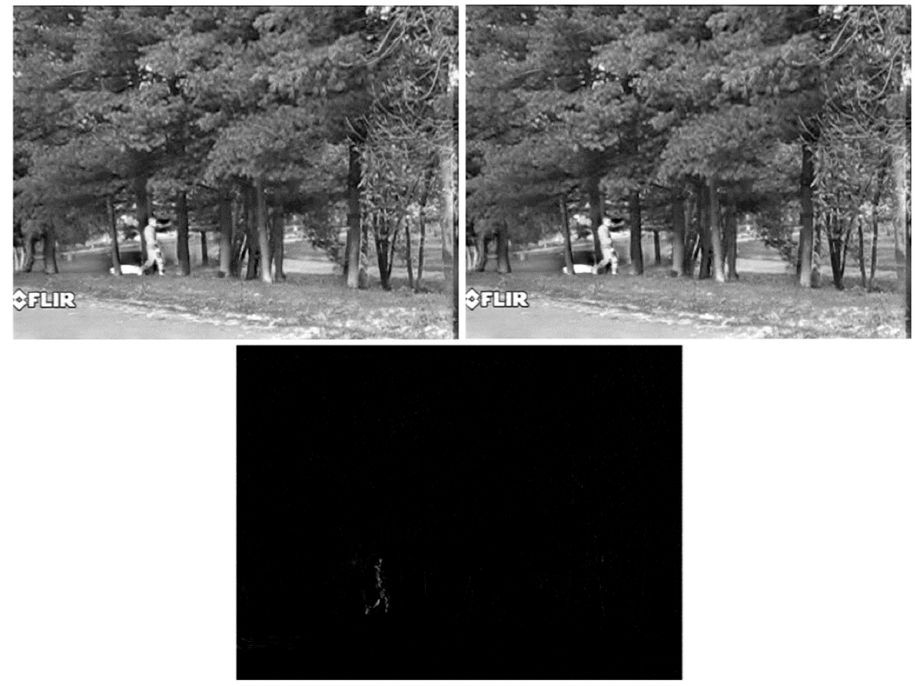
Figure 7. Fused two successive frames (top images) and difference image obtained between these two frames (bottom image).